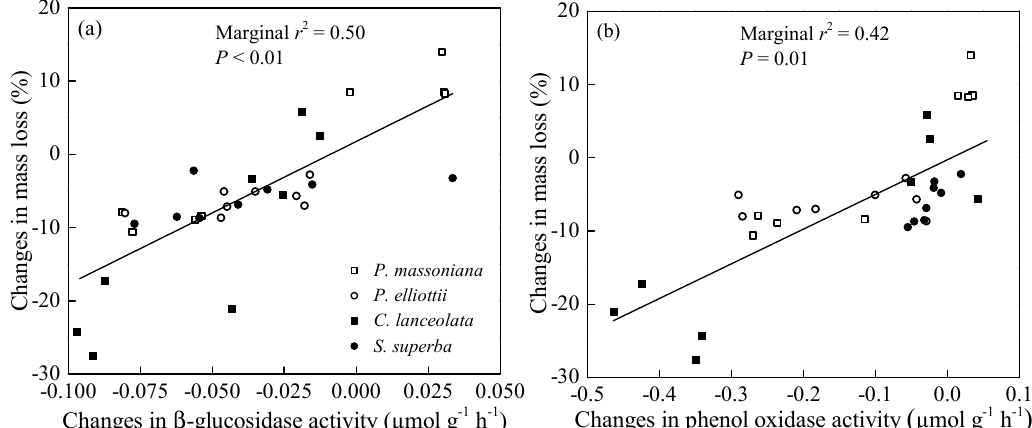
Figure 4. Relationships between changes in root litter mass loss and changes in activities of β - glucosidase ( a ) and phenol oxidase ( b ) induced by the presence of living roots and mycorrhizal hyphae.